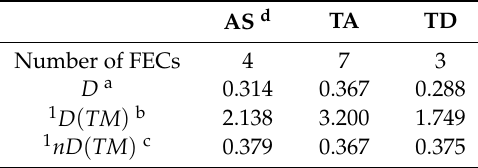
Table 5. Variation among populations in di ff erent locations ( β -diversity) for abundance Hellinger transformed data based on FECs of individual